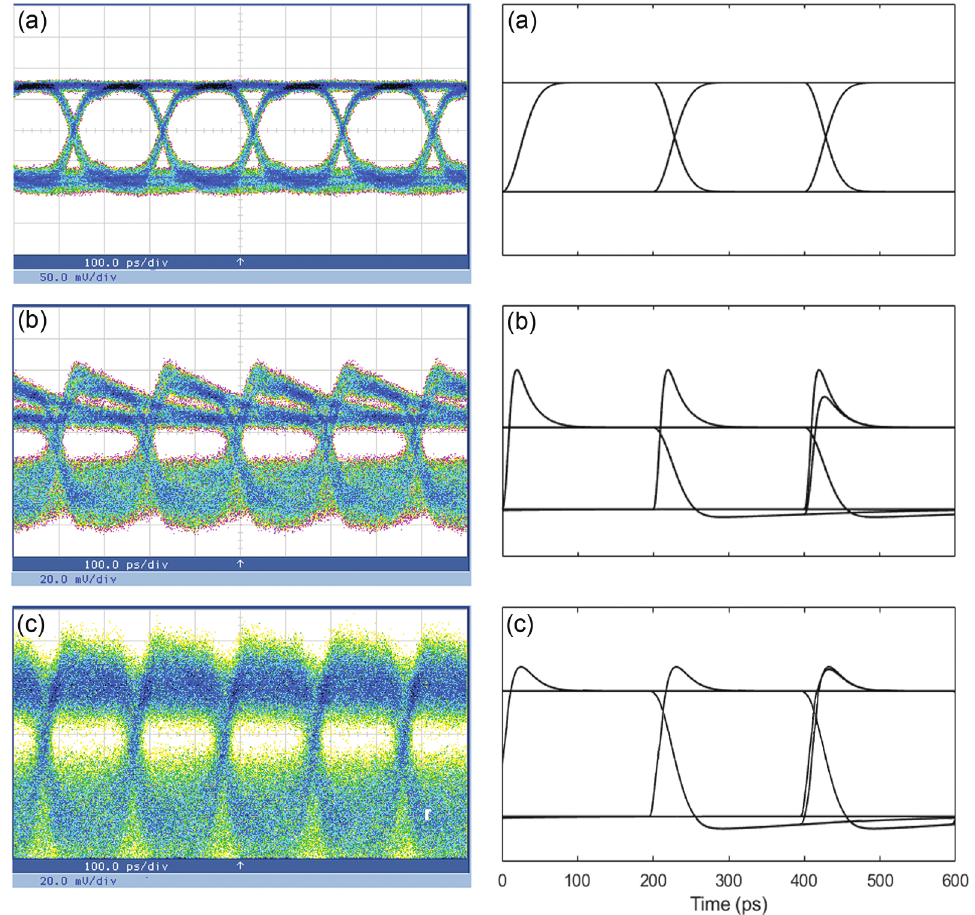
Figure 7. Measured eye diagrams ( left column) and simulated pseudo-eye diagrams ( right column) at the RSOA input ( a ), RSOA output ( b ) and BFL output ( c ).